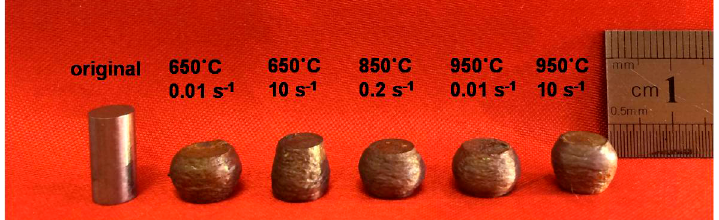
Figure 8. Specimens before and after deformation at the true strain of 0.7 under various deformation conditions.